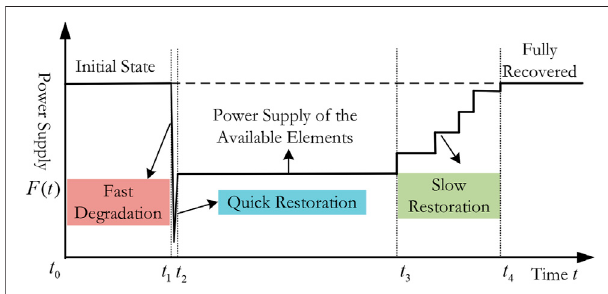
FIGURE1| Schematicdiagramoftheentireresilience process,from the occurrence of disturbances to the full recovery of the power network.